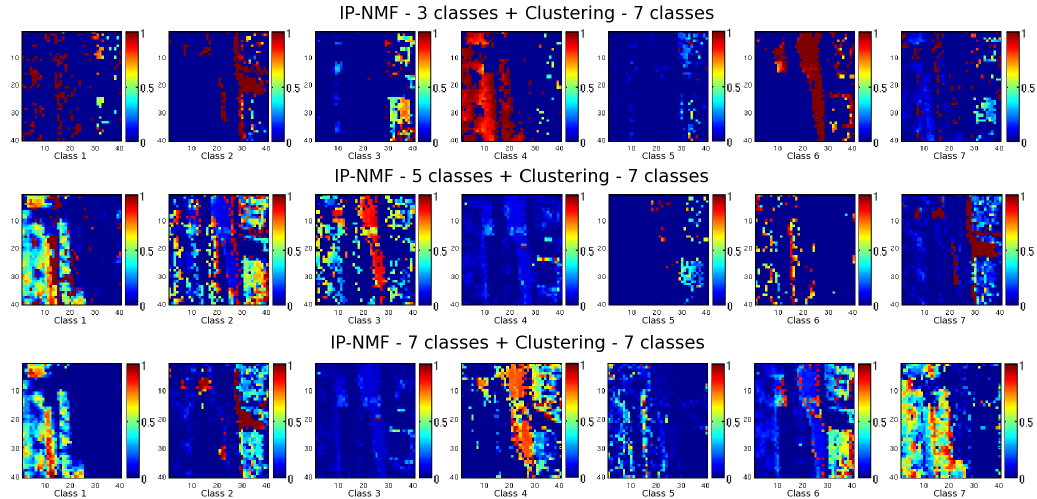
Figure 15. Abundance maps obtained with automated IP-NMF applied with M = 3 (1st line), M = 5 (2nd line) and M = 7 (3rd line) and followed by a clustering with seven